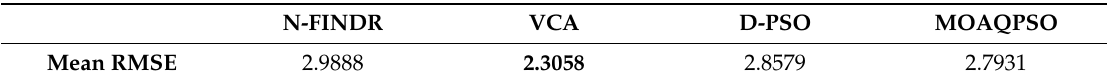
Table 6. Comparison between the RMSEs of N-FINDR, VCA, D-PSO, and